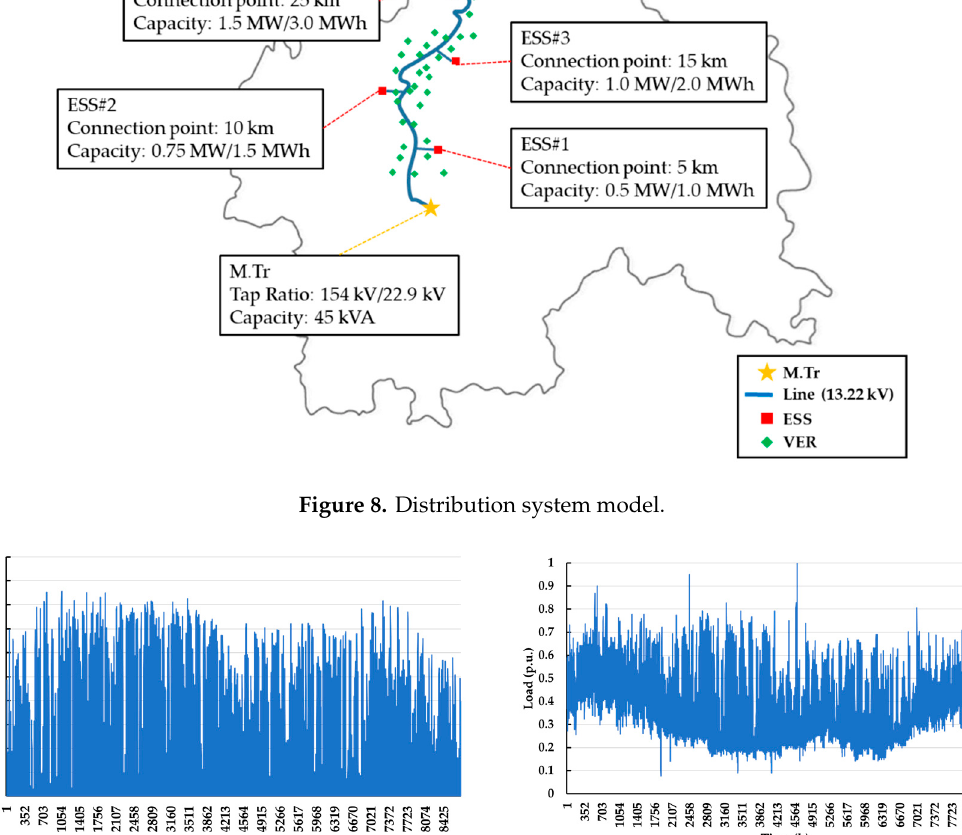
Figure 8. Distribution system model.